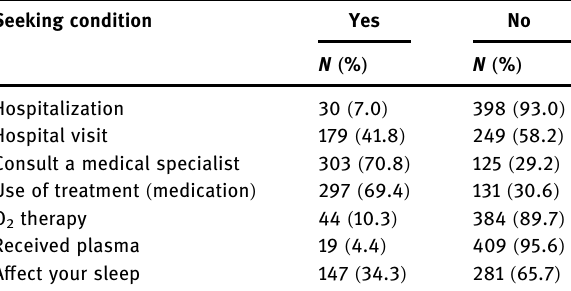
Table 3: Parameters of COVID - 19 severity II Seeking condition